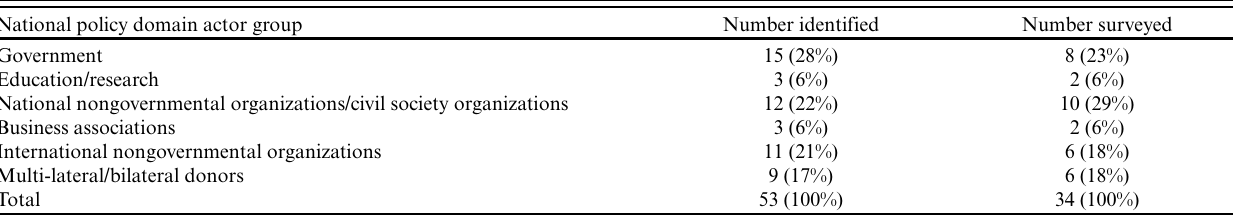
Table 3. Actor groups in the REDD+ policy domain in